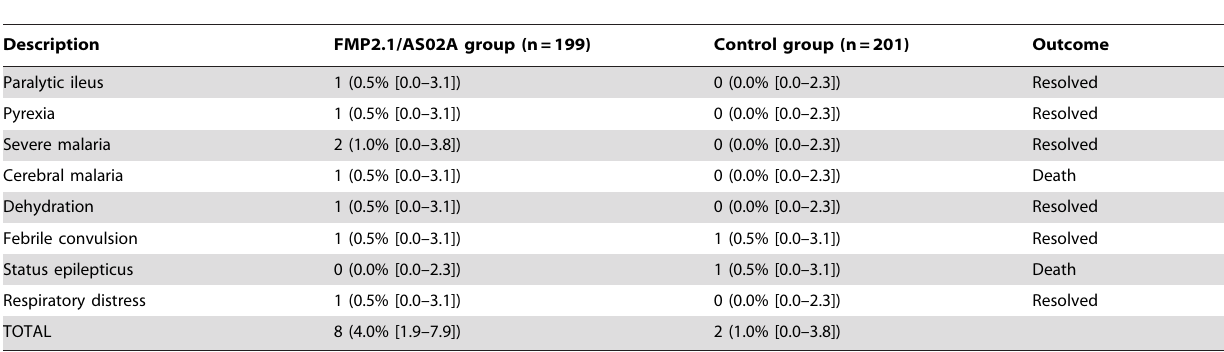
Table 1. Serious adverse events experienced by all subjects (months 0–24, all randomized participants).